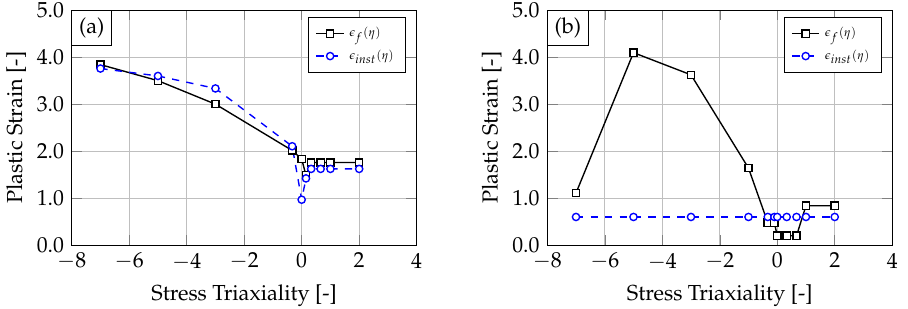
Figure A2. Implemented failure and instability parameters of GISSMO for the materials PA12 and PA6GF30 based on [15]: ( a ) PA12. ( b )